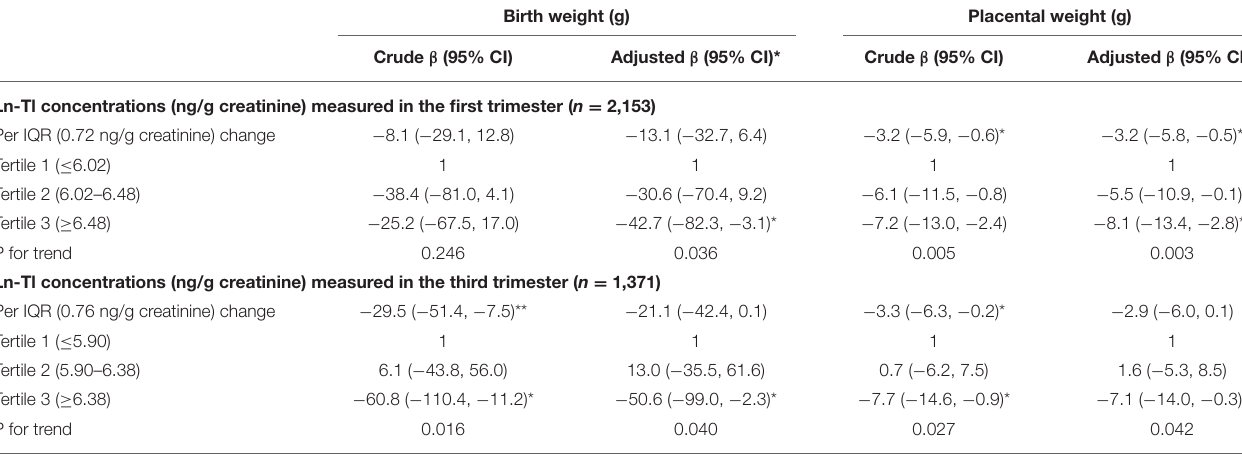
TABLE 2 | Associations of maternal exposure to Tl during pregnancy with birth weight and placental weight. Birth weight (g) Placental weight (g) Crude β (95% CI) Adjusted β (95% CI)* Crude β (95% CI) Adjusted β (95% CI)* Ln-Tl concentrations (ng/g creatinine) measured in the first trimester ( n = 2,153) Per IQR (0.72 ng/g creatinine)